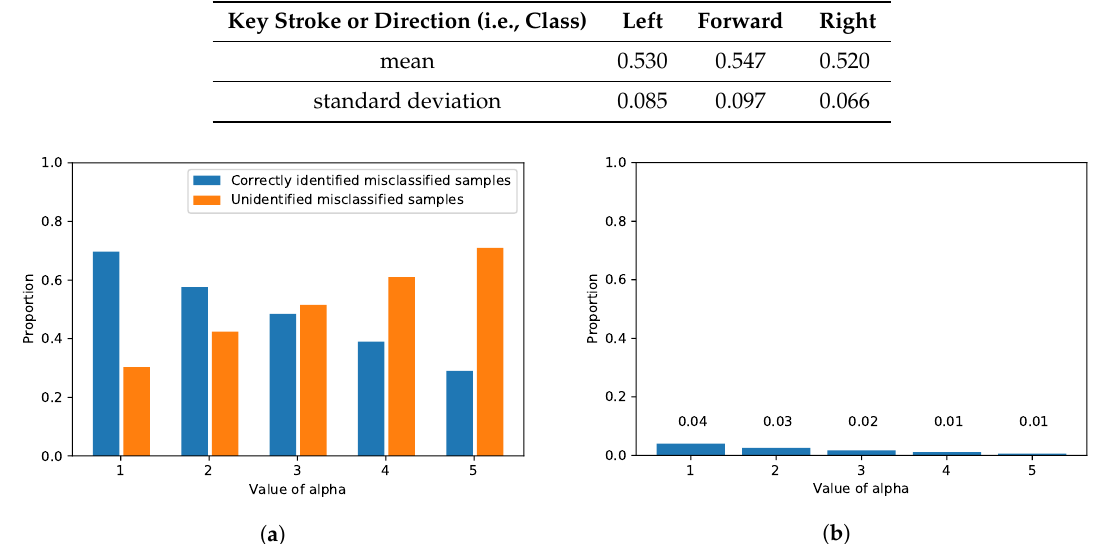
Figure 8. The detection performance of UFrame as to the IoT car image dataset is shown. ( a ) Among the misclassified samples by the CNN model, the proportions of the correctly identified samples (i.e., error flag was true) and those were are not (i.e., error flag was false) are shown in blue and orange, respectively. ( b ) Among the samples correctly identified by the CNN model, the proportion of the incorrectly identified samples (i.e., error flag was true) is shown with the corresponding